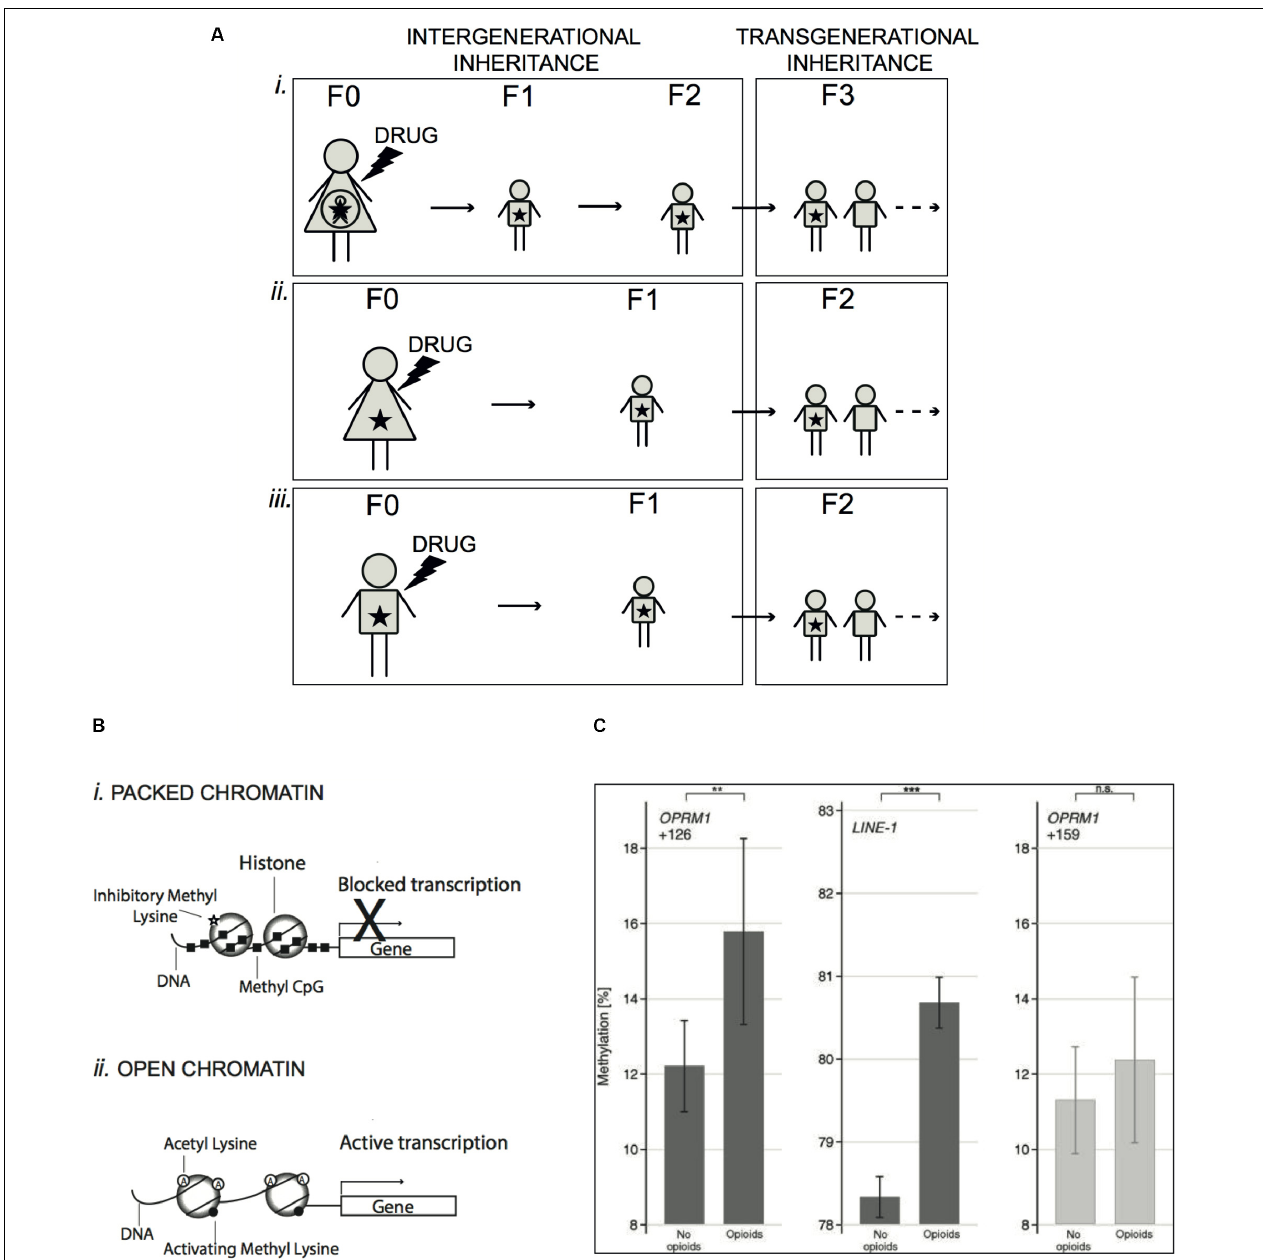
FIGURE 1 | Mechanisms of epigenetic inheritance induced by drug exposure. (A) Exposure of a pregnant female (F0) to a drug (prenatal exposure) implies also exposure in utero of the fetus and its own future germline (i). In this case, inherited epigenetic effects rising in the newborn (F1) and the direct descendants (F2) are considered as intergenerational, because cells of the future organism were directly exposed. Only epigenetic changes preserved in the following generations (F3 and after) are transgenerational, as manifesting in the absence of any exposure. On the other hand, exposure can occur in females (ii) or males (iii) prior to pregnancy (parental exposure), thus potentially touching the germline, which will produce the next generation (F1). In this case, inherited epigenetic alterations will be considered as transgenerational already in the F2 generation and beyond. (B) Schematic representation of epigenetic mechanisms. In chromatin, DNA is wrapped around individual histone proteins. DNA methylation at CpG dinucleotides (Methyl CpG) and methylation of histones at specific lysine residues are associated to a condensed chromatin structure, where DNA is less accessible to transcription factors, which results in silenced transcription (i). In contrast, acetylation of histones and specific histone methylation favors a more open structure of the chromatin, which allows the recruitment of transcription factors and activation of transcription (ii). (C) DNA methylation (means and 95% confidence intervals) at OPRM1 gene (position +126 counted from the adenine of the start codon, left panel) and LINE-1 (long-interspersed nuclear elements – central panel) in a cohort of 132 chronic pain patients of whom 62 were treated with opioid analgesics for more than 1 year. Methylation was higher in the opioid-treated patients than in age-matched non-opioid-treated pain patients. The significances ( ∗∗ P < 0.01, ∗∗∗ P < 0.001) are the results of t -test comparisons between groups. For comparison of the specificity of the hypermethylation at position +126 of the OPRM1 gene, a non-significant position (+159) is shown at right. Data shown in C panel are from Doehring et al. (2013) (License No. 4331930562761).